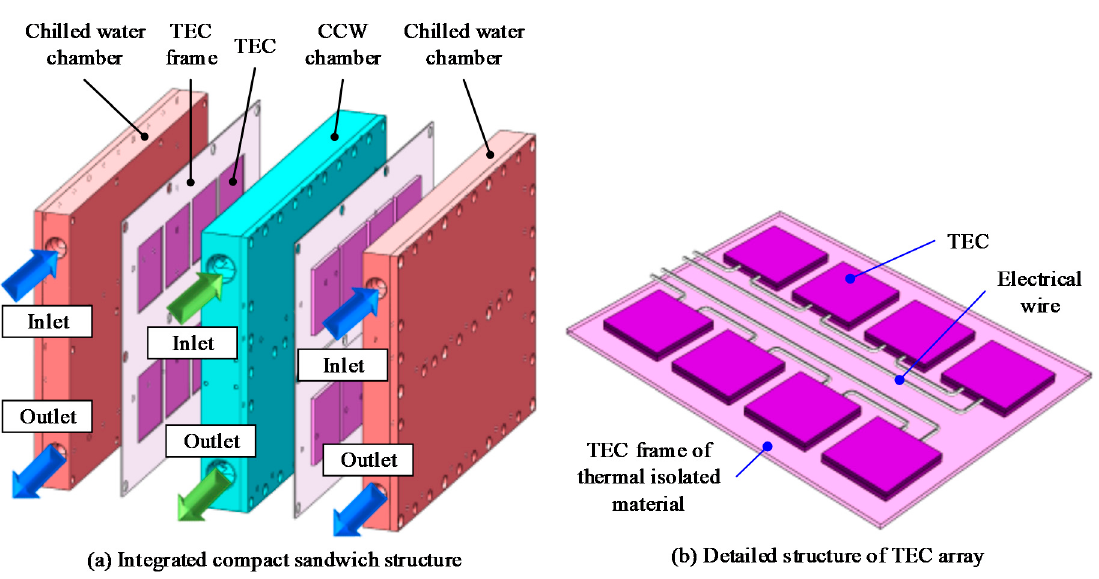
Figure 6. Scheme of the thermoelectric chip (TEC) cooling module.